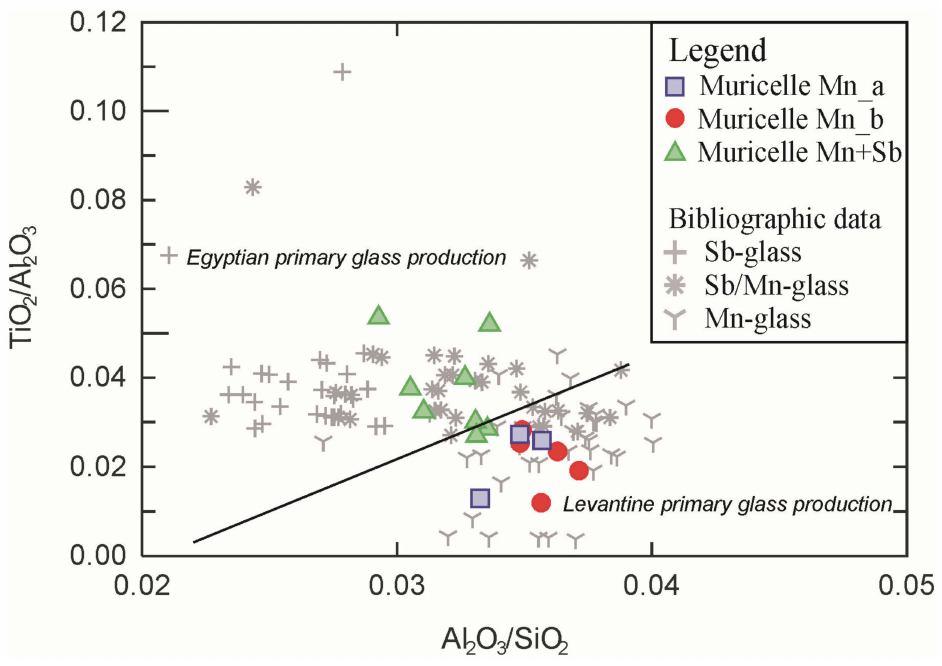
Figure 6. Al 2 O 3 /SiO 2 versus TiO 2 /Al 2 O 3 . The bibliographic data refer to coeval Roman glasses